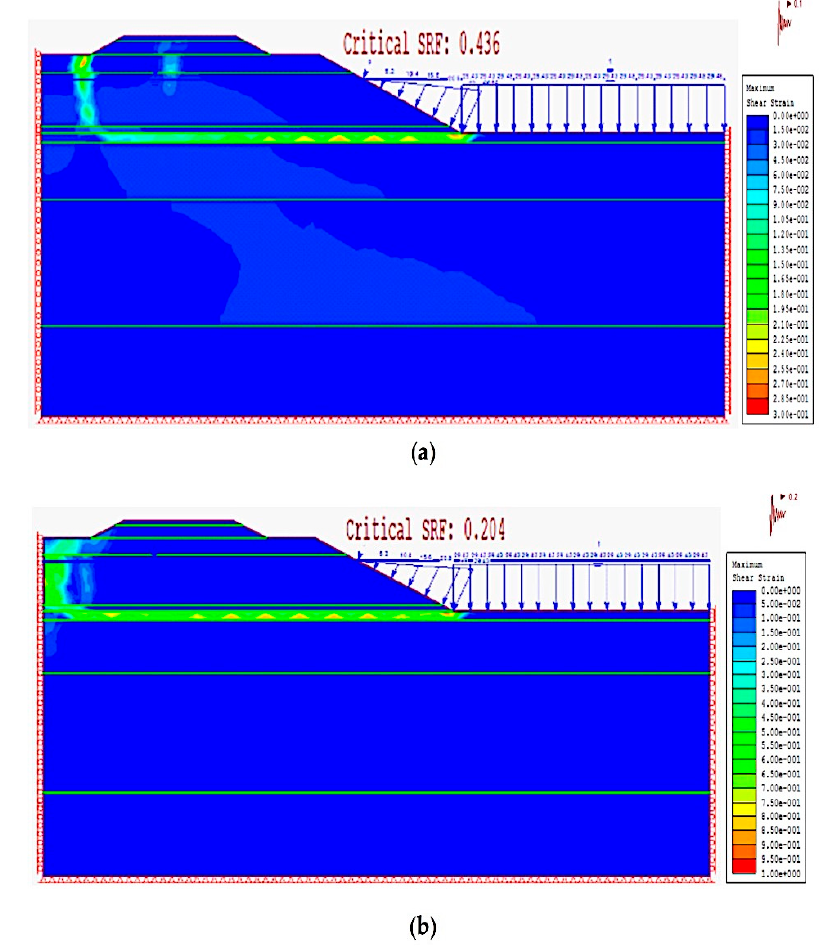
Figure 17. Colored contour shading of shear strain at earthquake acceleration changed by ( a ) 0.1 g and ( b ) 0.2 g.